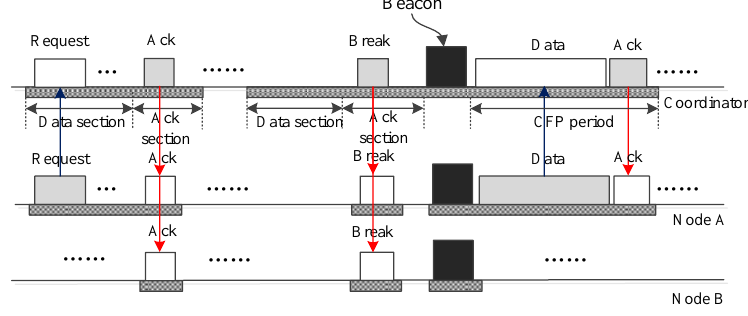
Figure 15. The case that a break is postponed.